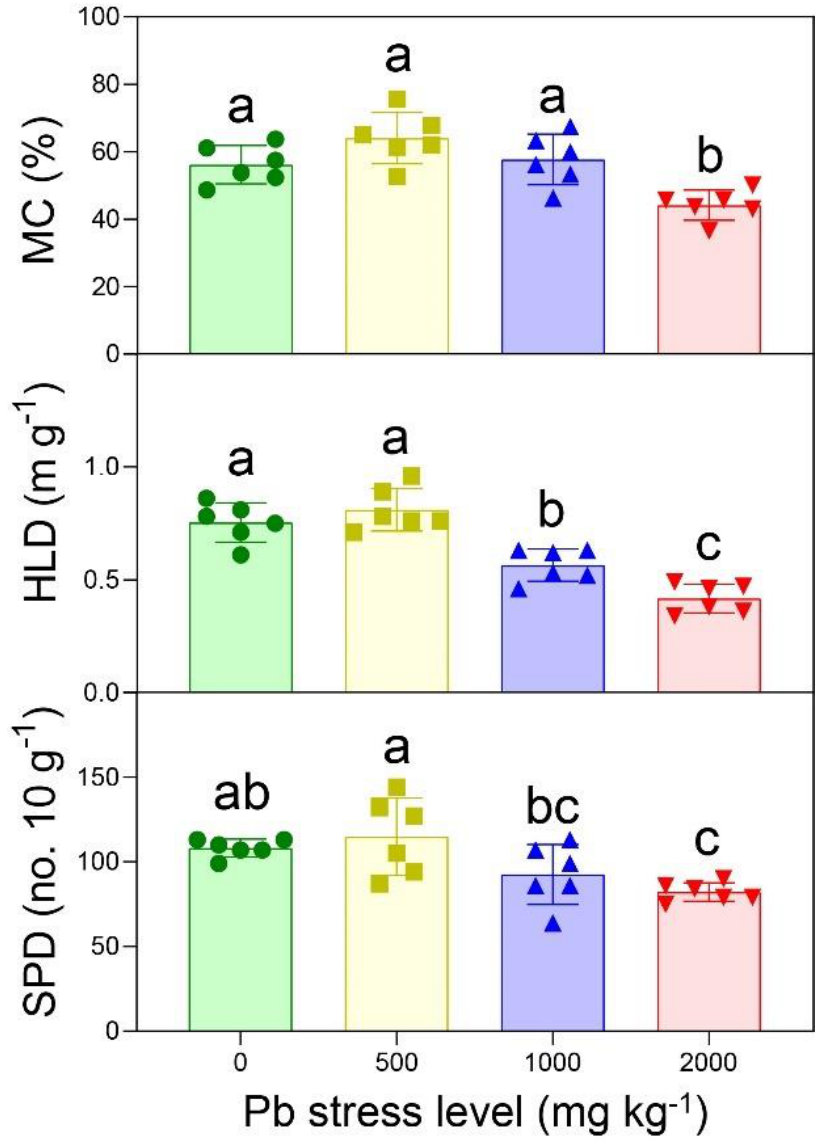
Figure 2. Mycorrhizal colonization (MC), spore density (SPD), and hyphal length density (HLD) of AMF under different Pb − stress levels (0, 500, 1000, and 2000 mg kg − 1 ). Data represent mean ± SD for biological replicates ( n = 6). The same letter indicates no significant difference (Duncan’s test, p < 0.05).